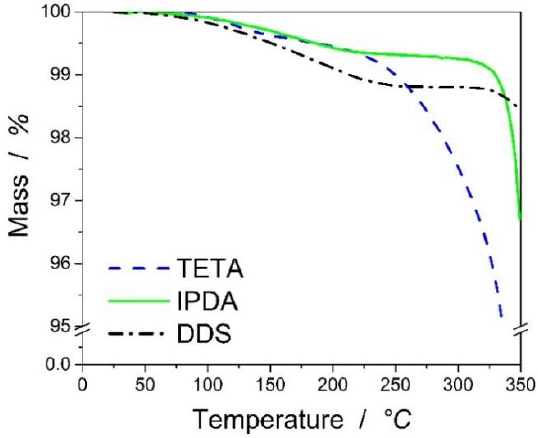
Figure 2. TGA of the resin under air atmosphere at 10 K/min heating rate.